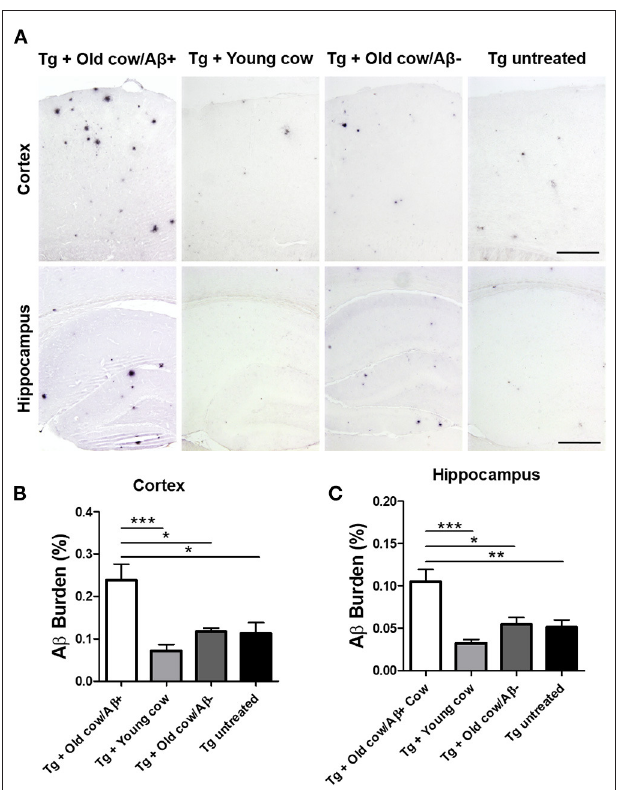
FIGURE 3 | Acceleration of amyloid pathology in transgenic mice by injecting A β − rich cow brain extract. APP/PS1 double transgenic mice (30–40 days old) were injected intra-cerebrally (both hemispheres at the level of the hippocampus) with 10 µ L of 40% (w/v) brain extracts of a young cow or old cows with (A β + ) or without (A β − ) A β . Control animals were left untreated. Animals were sacrificed at 6 months of age and their brains were fixed for histological analysis. (A) Representative pictures of 4G8 immunostaining of the cortex and hippocampal areas. Scale bar: 250 µ m. A β burden was quantified by image analysis in the cortex (B) and the hippocampus (C) . Data corresponds to the average ± standard error of the mean of all animals analyzed in each group ( n = 7–9). Differences were analyzed by one-way ANOVA followed by the Tukey’s multiple comparison post-test. * p < 0.05, ** p < 0.01, *** p < 0.001.